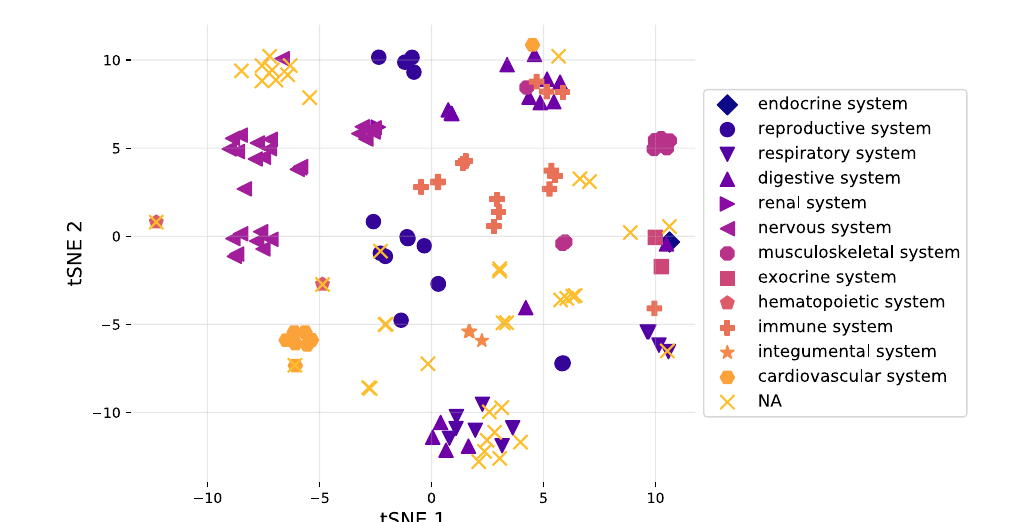
Fig.4|NLP-MLmodelsofanatomicallyrelatedtissuesaresimilartoeachother. tSNE visualization of standardized logistic regression model coef fi cients for NLP- MLmodelsofalltissuesandcelltypestrainedonthefullgoldstandard.Tissue/cell- type terms with similar models are close to each other on this plot. Colors and